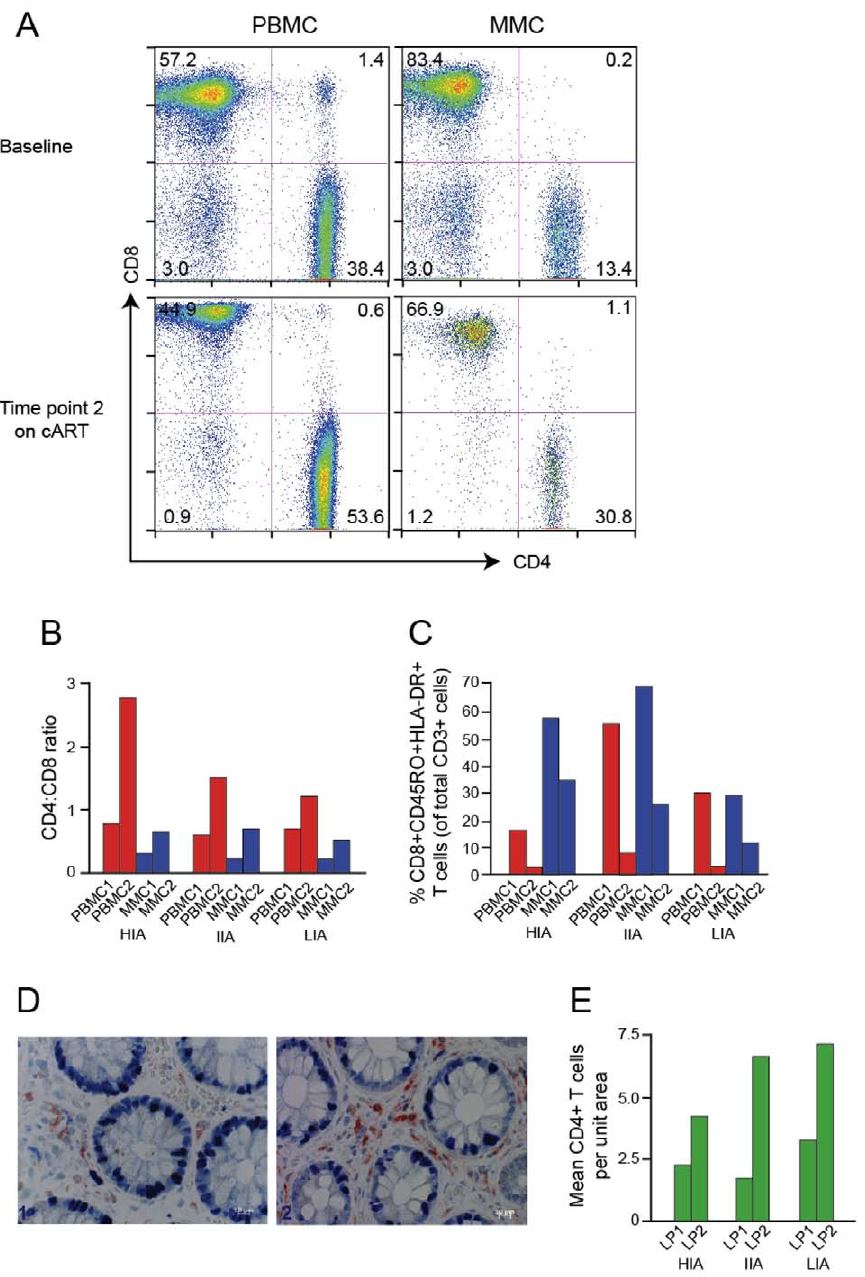
Figure 1. Immunological profiles of experimental patients before and after initiation of cART. (A) Representative flow plots from low immune activator patient (LIA) are depicted. CD8 + T cells are shown on the x -axis and CD4 + T cells on the y -axis. (B, C) Bar graphs depicting CD4:CD8 ratio (B) and levels of immune activation (C) of PBMC (red bars) and MMC (blue bars) before (PBMC1 and MMC1) and after (PBMC2 and MMC2) initiation of antiretroviral therapy. High immune activator (HIA), intermediate immune activator (IIA) and low immune activator (LIA) are compared. (D, E) Immunohistochemical characterization of immune effector sites in rectosigmoid biopsies. Using a PC-based image-analysis system (KS 4000, Kontron) a standard area was set by the image analyzer. A total of between 10 and 15 consecutive non-overlapping fields were analyzed. In figure (D), a biopsy section (viewed at 40 6 magnification) compares CD4 + T cells (stained red) of subject IIA before (left panel) and after (right panel) initiation of antiretroviral therapy. Figure (E) depicts mean CD4 + T before (LP1) and after (LP2) initiation of antiretroviral therapy. HIA, IIA and LIA are